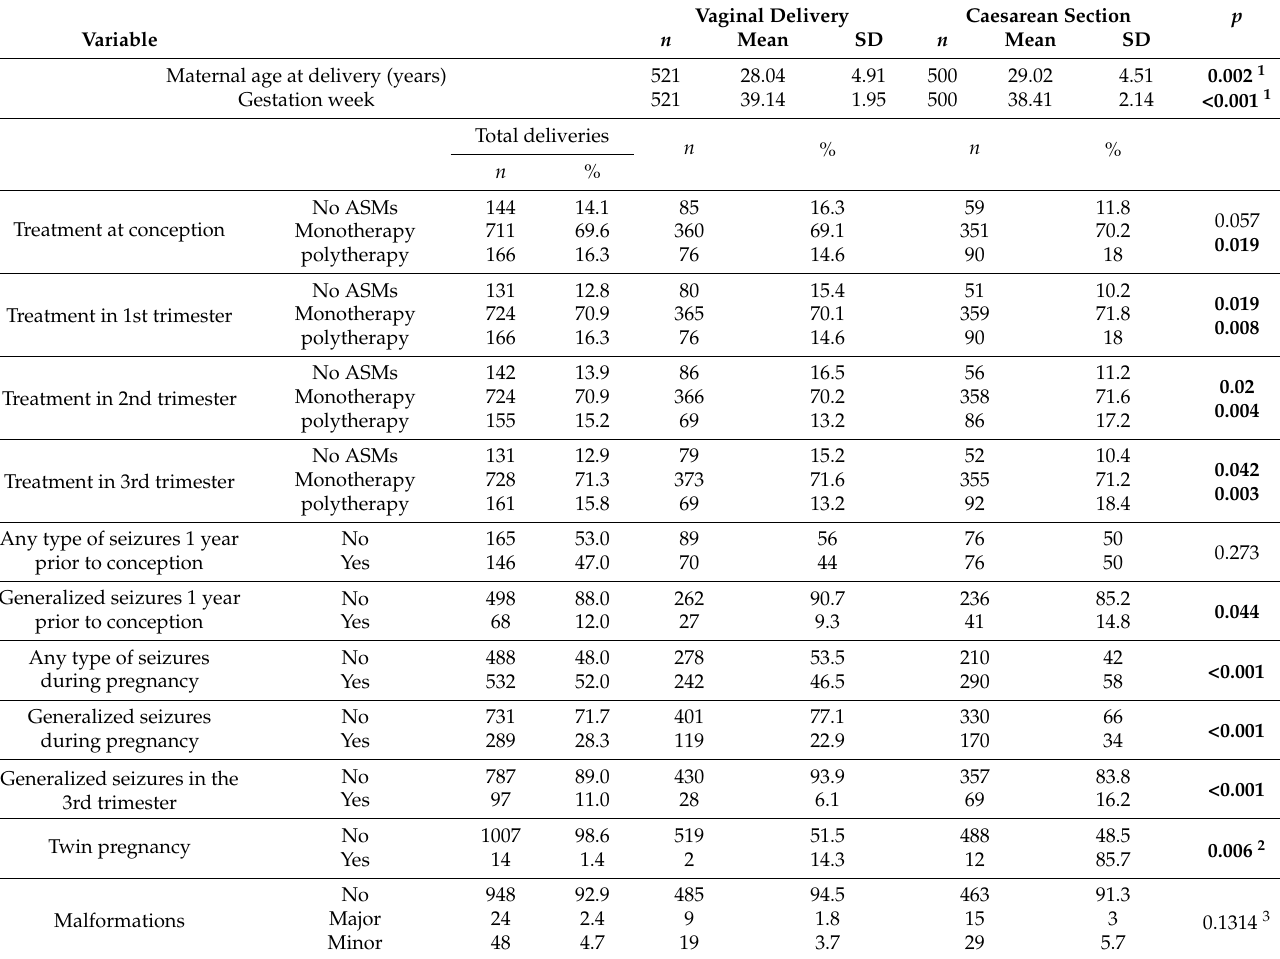
Table 1. General clinical descriptive of WWE pregnancies and according to the mode of delivery ( n =